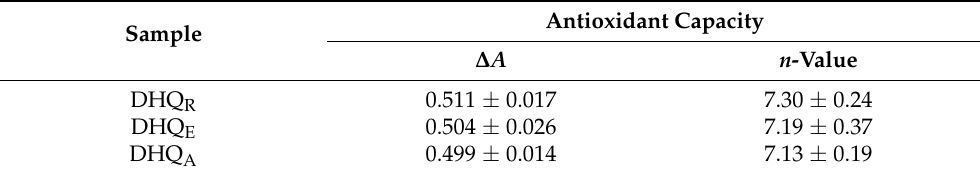
Table 3. Antioxidant capacity of the DHQ